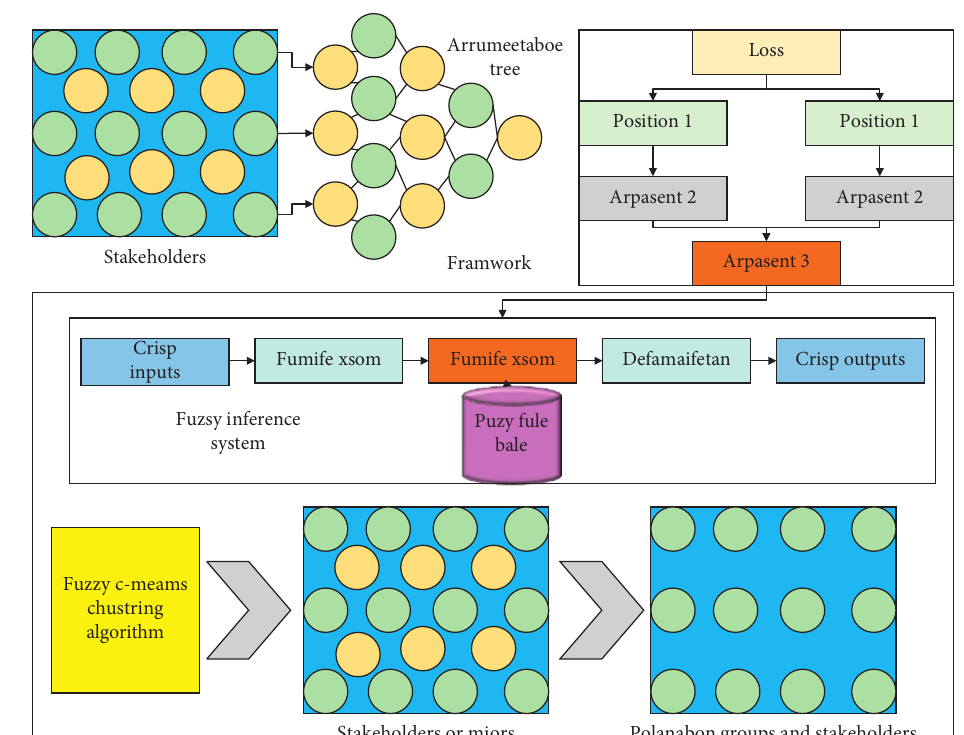
Figure 3: Database table E-R